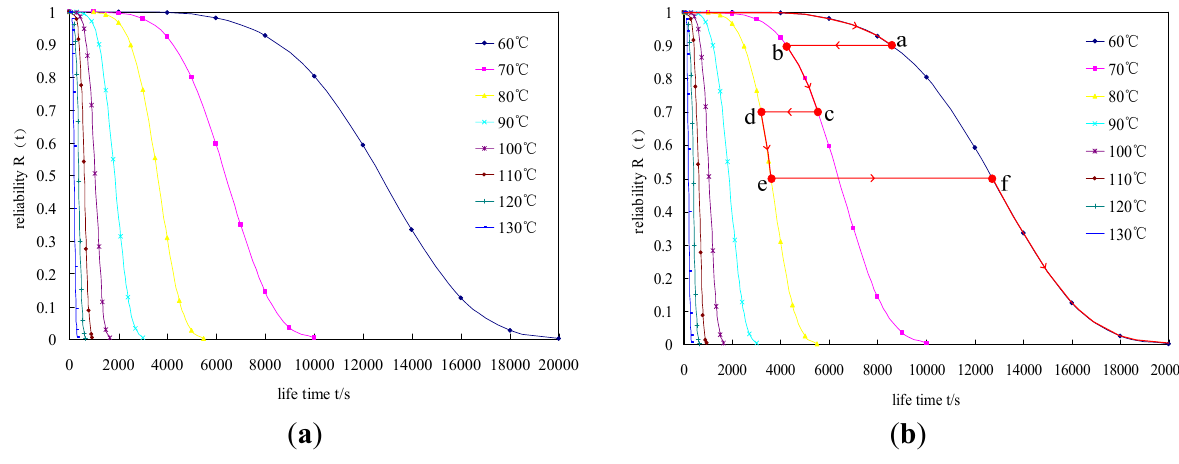
Figure 4. ( a ) Relationship curve between reliability and time under different